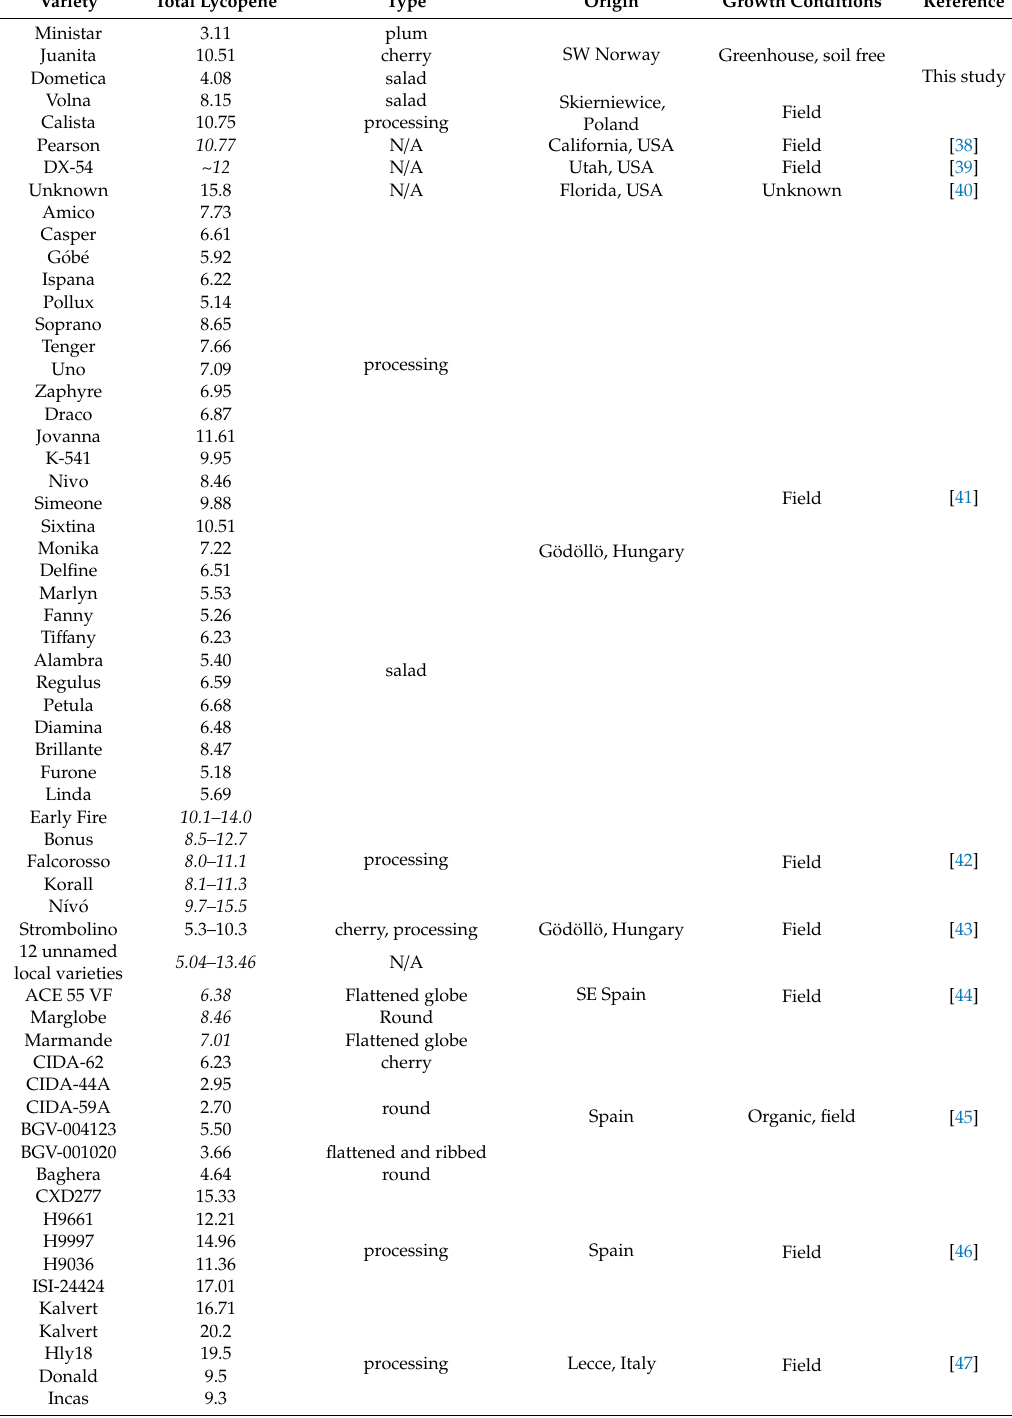
Table 1. Lycopene content in tomato varieties (converted to mg / 100 g fresh weight (FW)). Literature review. Values in italics are obtained by spectrophotometry, otherwise high-performance liquid chromatography